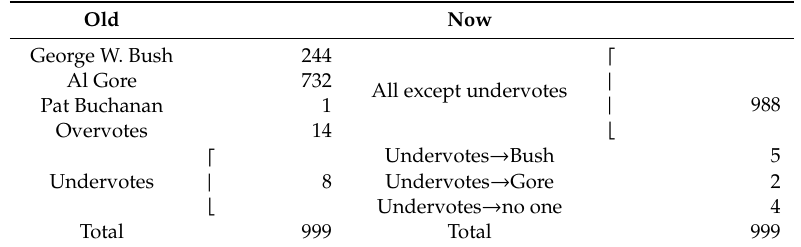
Table 3. Vote tallies for the Crocodile Corridor precinct (2000 election, Scenario